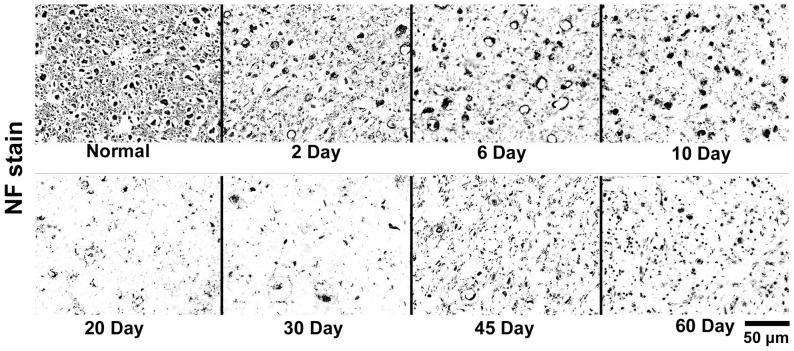
NF stained histological images of cat's pons.The NF images of the normal side and the degenerated side of pons at 2nd, 6th, 10th, 20th, 30th, 45th and 60th day after modeling were displayed. Scale bar, 50 µm.